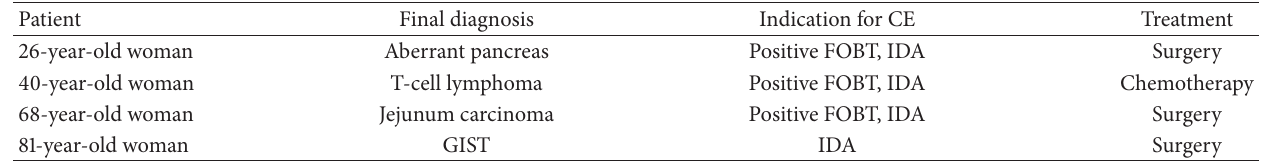
Table 3: Cases of occult OGIB due to tumor.